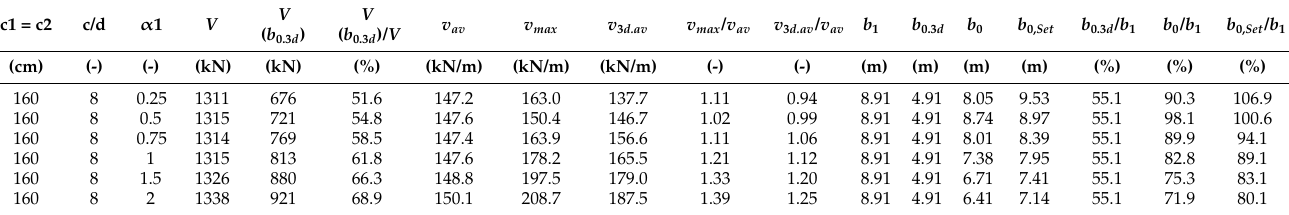
Table A6. Analysis of the shear force distribution in the control perimeter 2 d with 160 cm shear cap